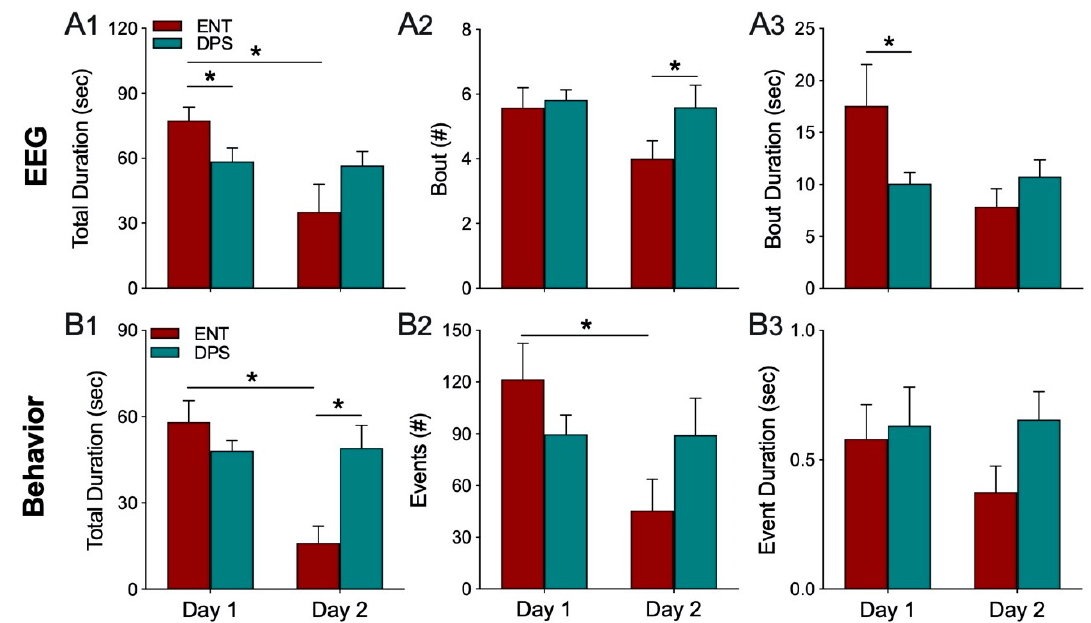
Figure 4. Theta dominance in the EEG ( A1 – A3 ) and exploration behavior ( B1 – B3 ) over both days of the object exploration task. In the ENT condition, both the total duration of time when EEG epochs had a T/D ratio > 1.0 ( A1 ) and total time animals explored the object ( B1 ) decreased significantly from day 1 to 2. The number of theta-dominated bouts ( A2 ) and exploration events ( B2 ) followed a similar pattern, as did the mean duration of bouts of theta ( A3 ) and exploration ( B3 ). By contrast, there were no changes from day 1 to 2 in any of these parameters in the DPS condition. Data expressed as mean (± SEM). * indicates significant differences ( A1 – A3 , n = 12; B1 – B3 , n = 8); see text for p values.